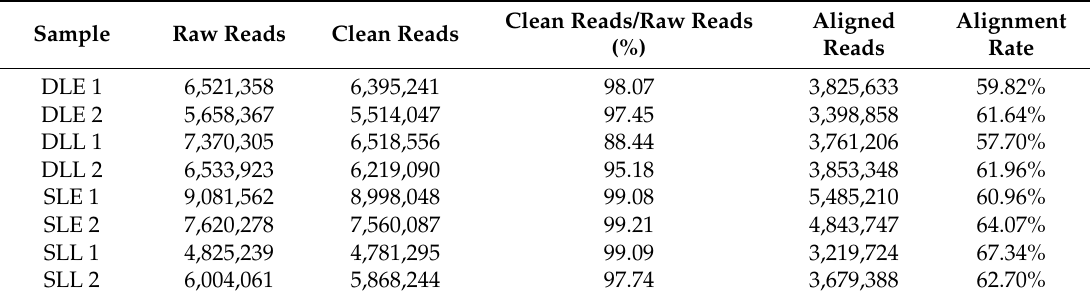
Table 1. Data quality and alignment analysis.